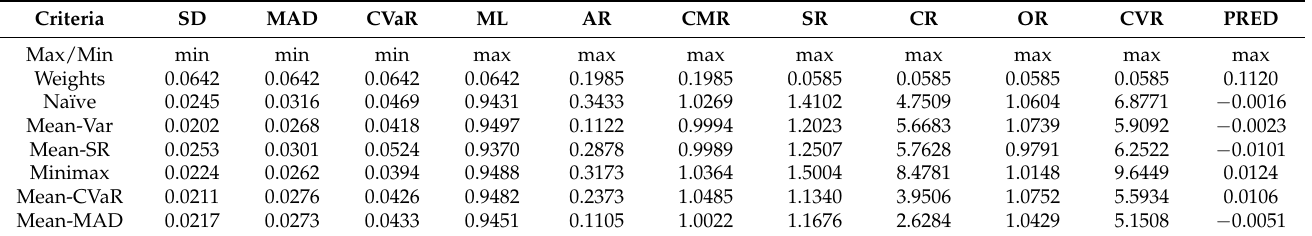
Table 2. Evaluation matrix.